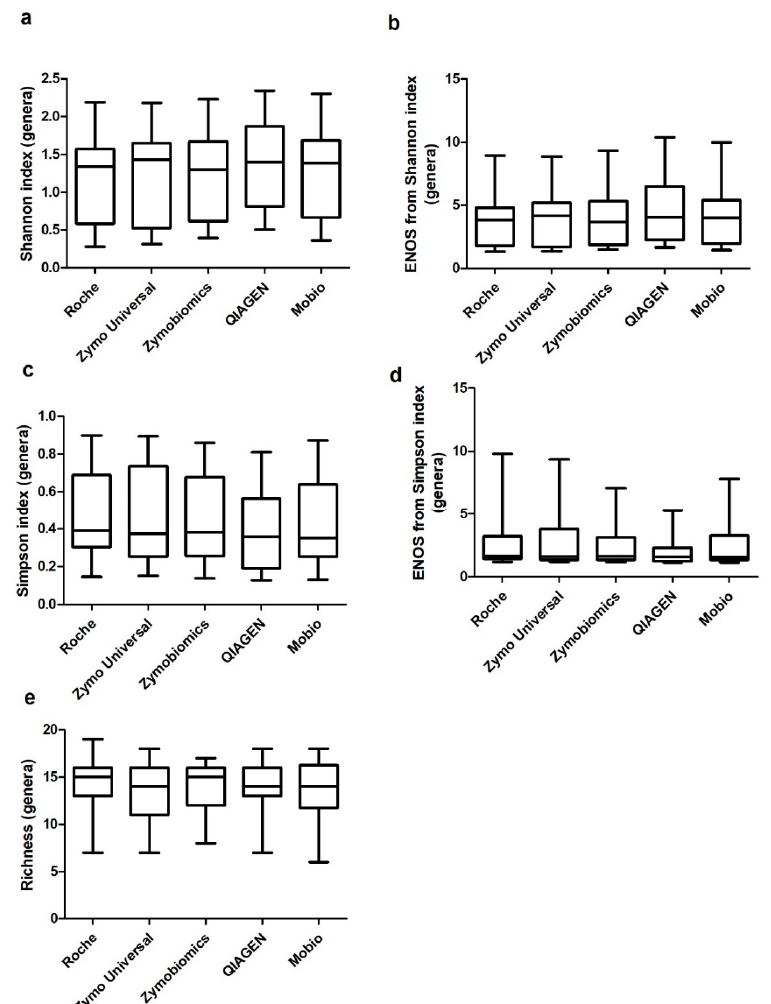
Figure 5. Comparison of median levels of ( a ) the Shannon index, ( b ) effective number of species (ENOS) from Shannon, ( c ) the Simpson index, ( d ) ENOS from the Simpson index, and ( e ) richness across the five analyzed commercial kits (Experiment 3).